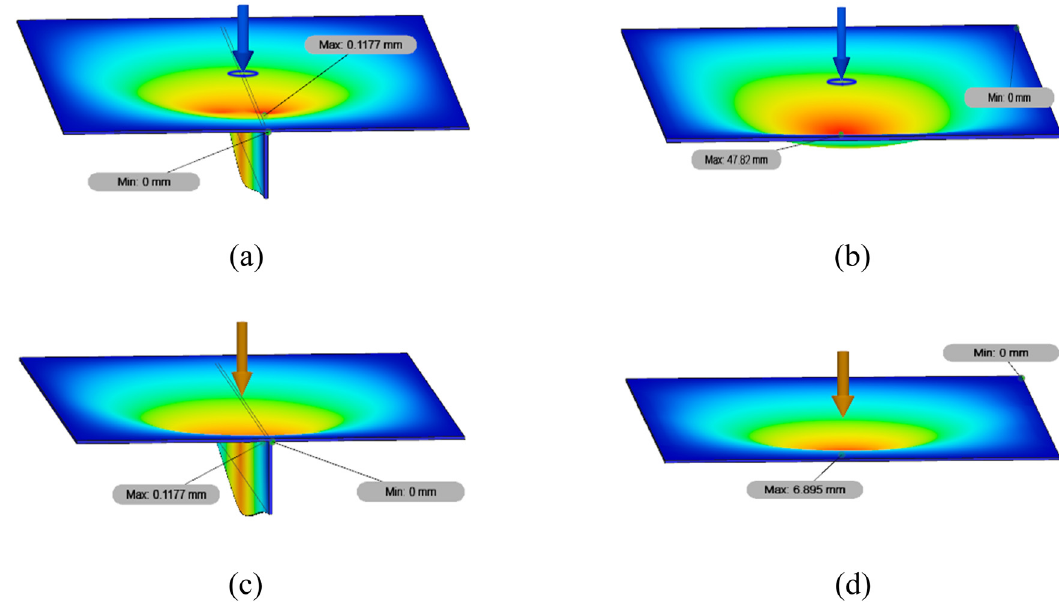
Figure 13: The contour of displacement at a load angle of 0° between sti ff ened and unsti ff ened low - carbon steel with a centred load ( Models 1 and 3 ) and medium - carbon steel with a global linear load ( Models 6 and 8 ) : ( a ) Model 1, ( b ) Model 3, ( c ) Model 6, and ( d ) Model 8.